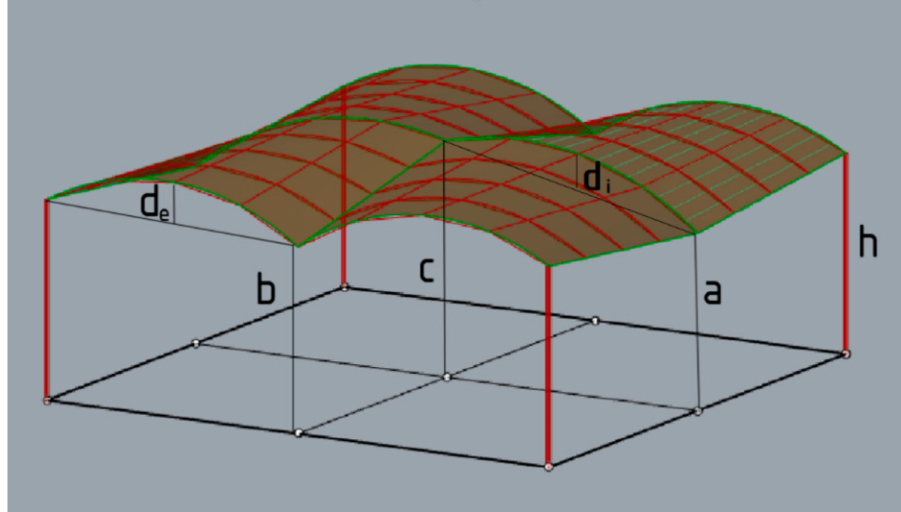
Figure 4. An example of the four-unit